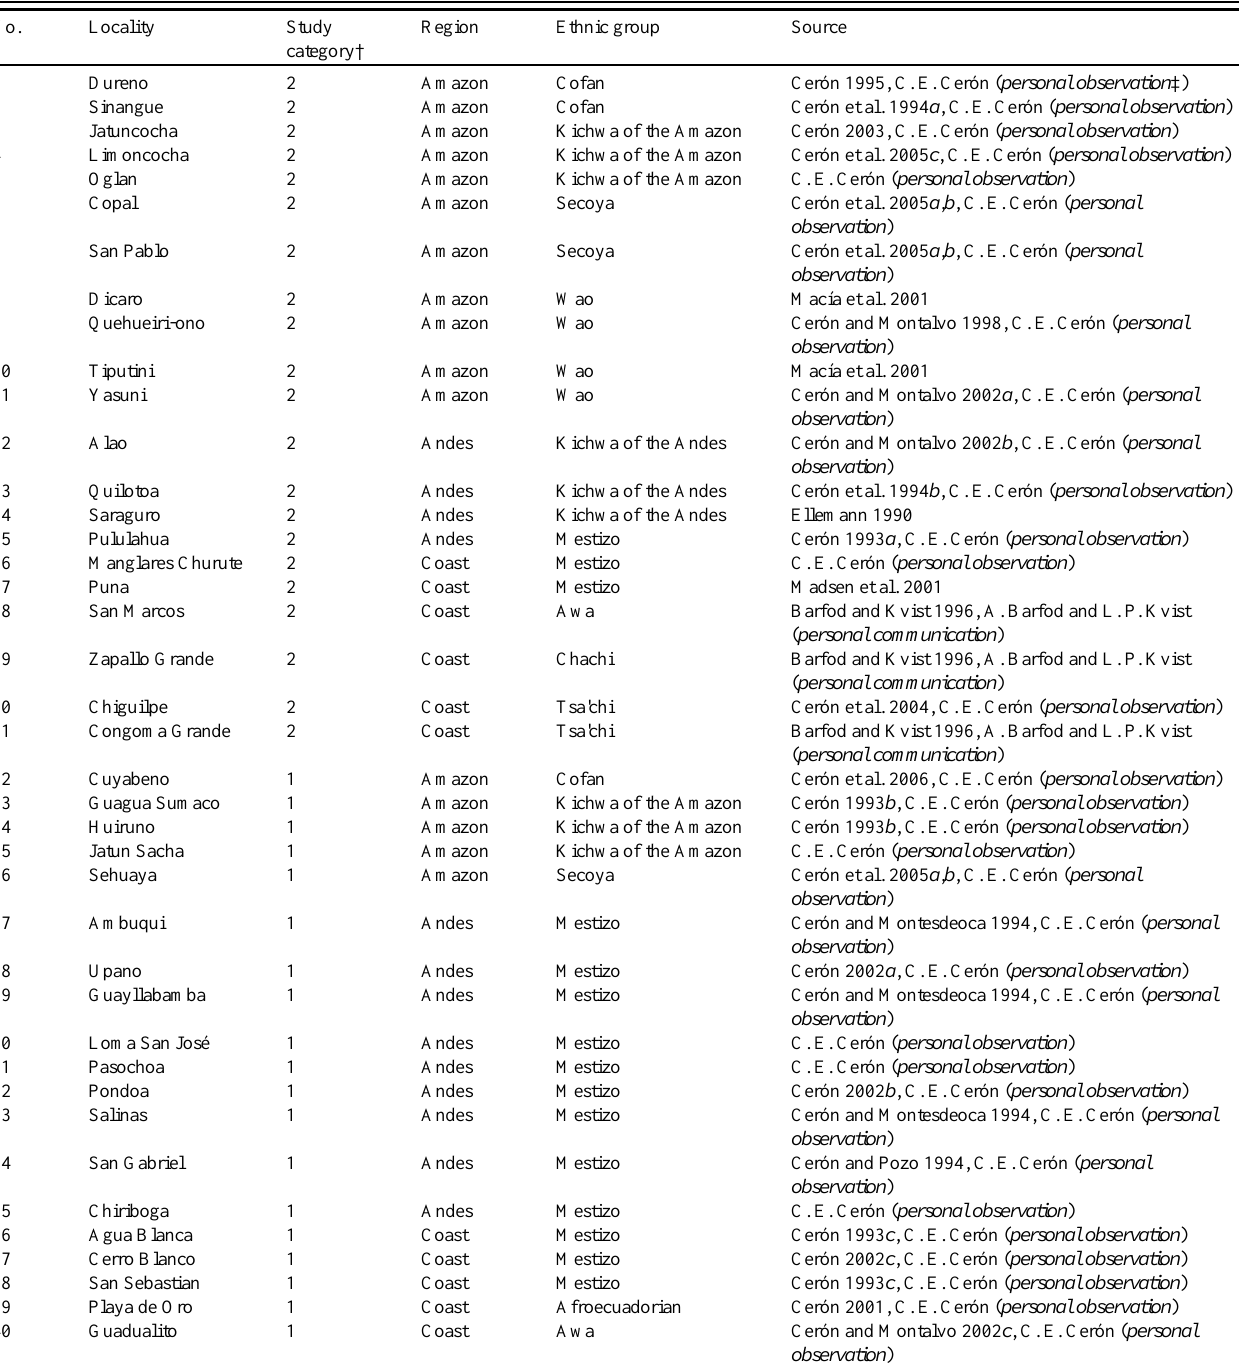
Table 1. Ecuadorian localities selected for the assessment of determinants of their plant use richness and use patterns.